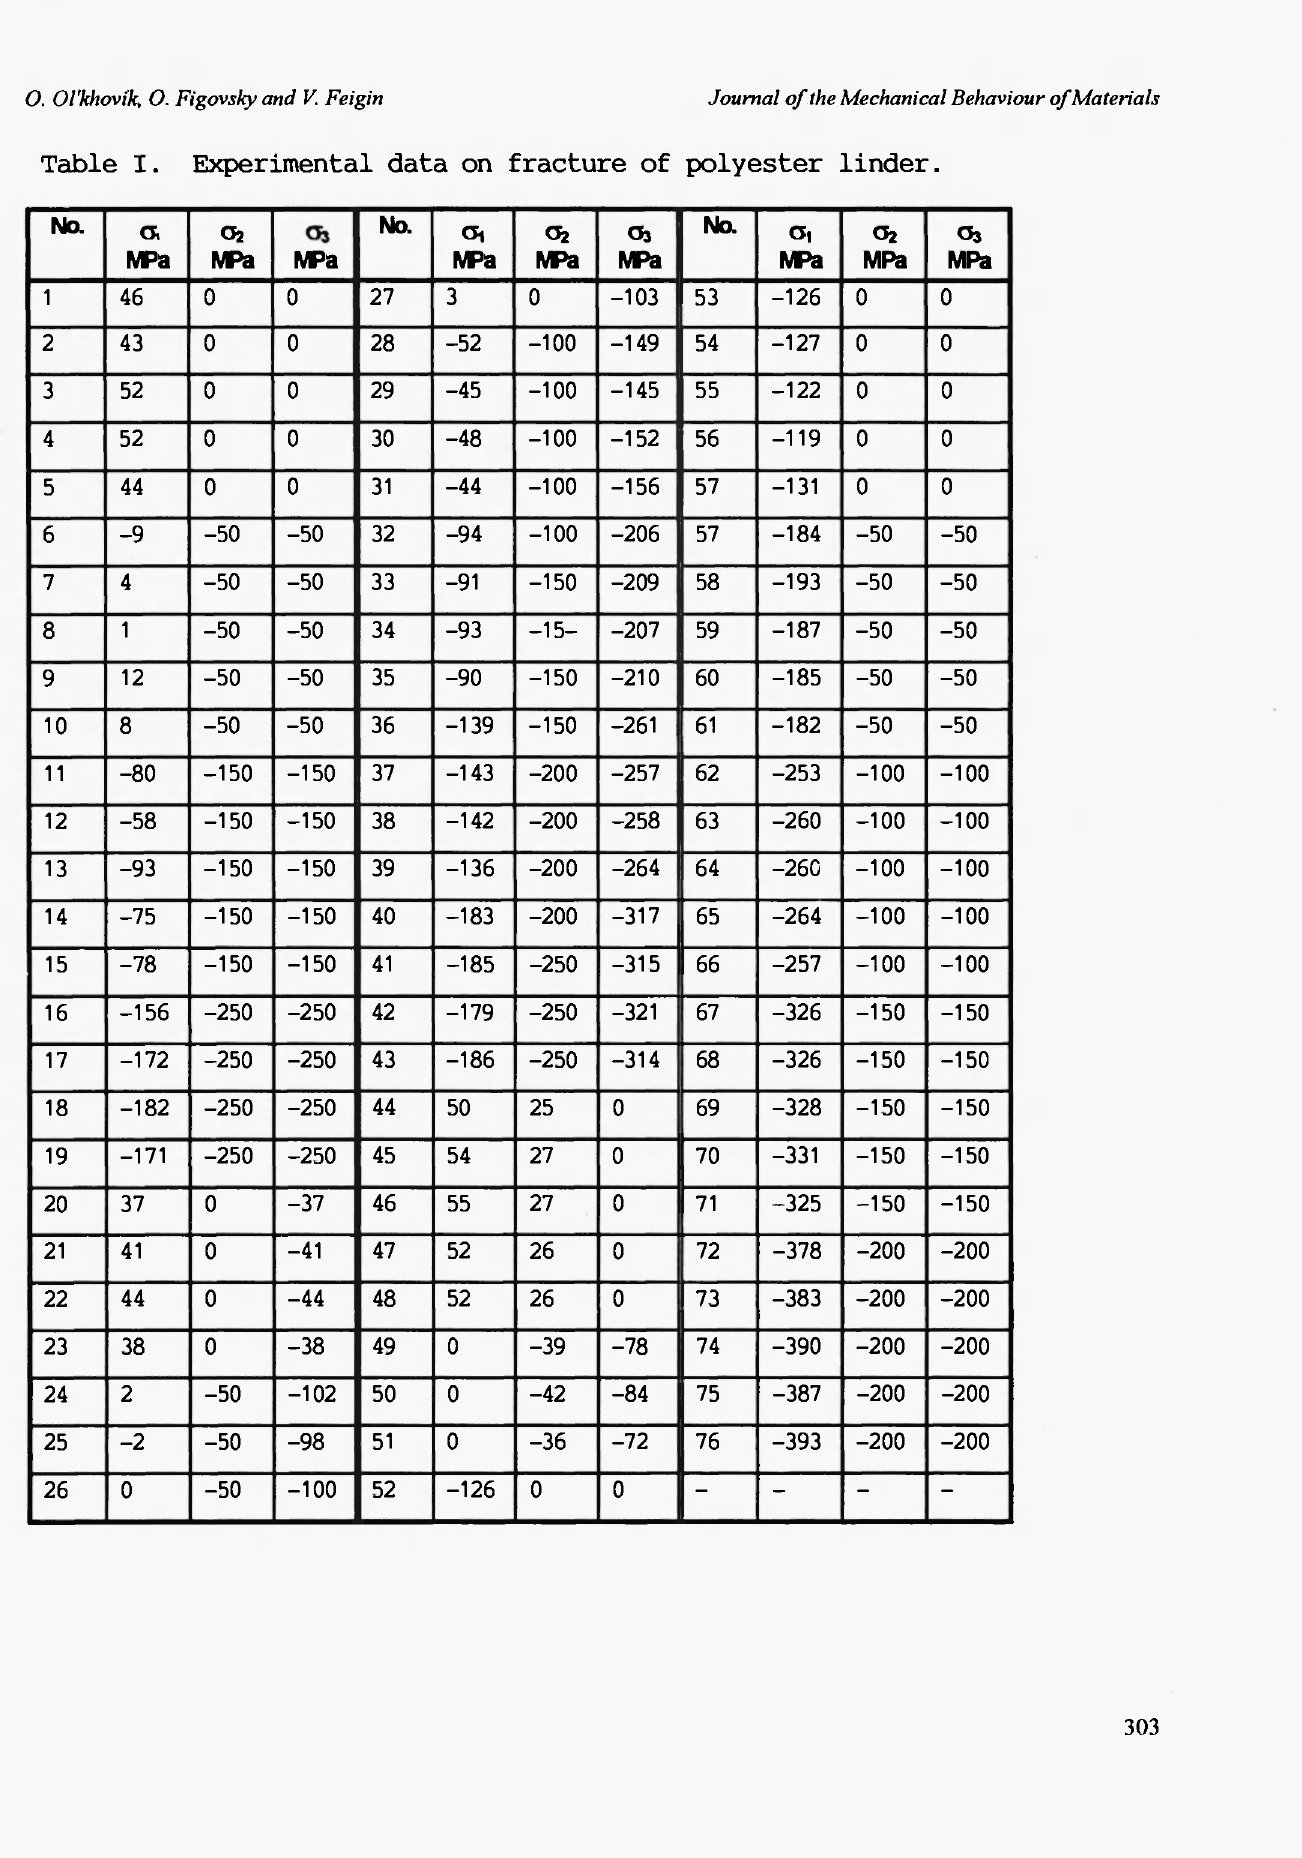
Table I. Experimental data on fracture of polyester